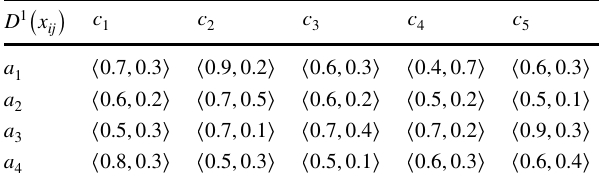
Table 4 Pythagorean fuzzy matrix given by expert 1